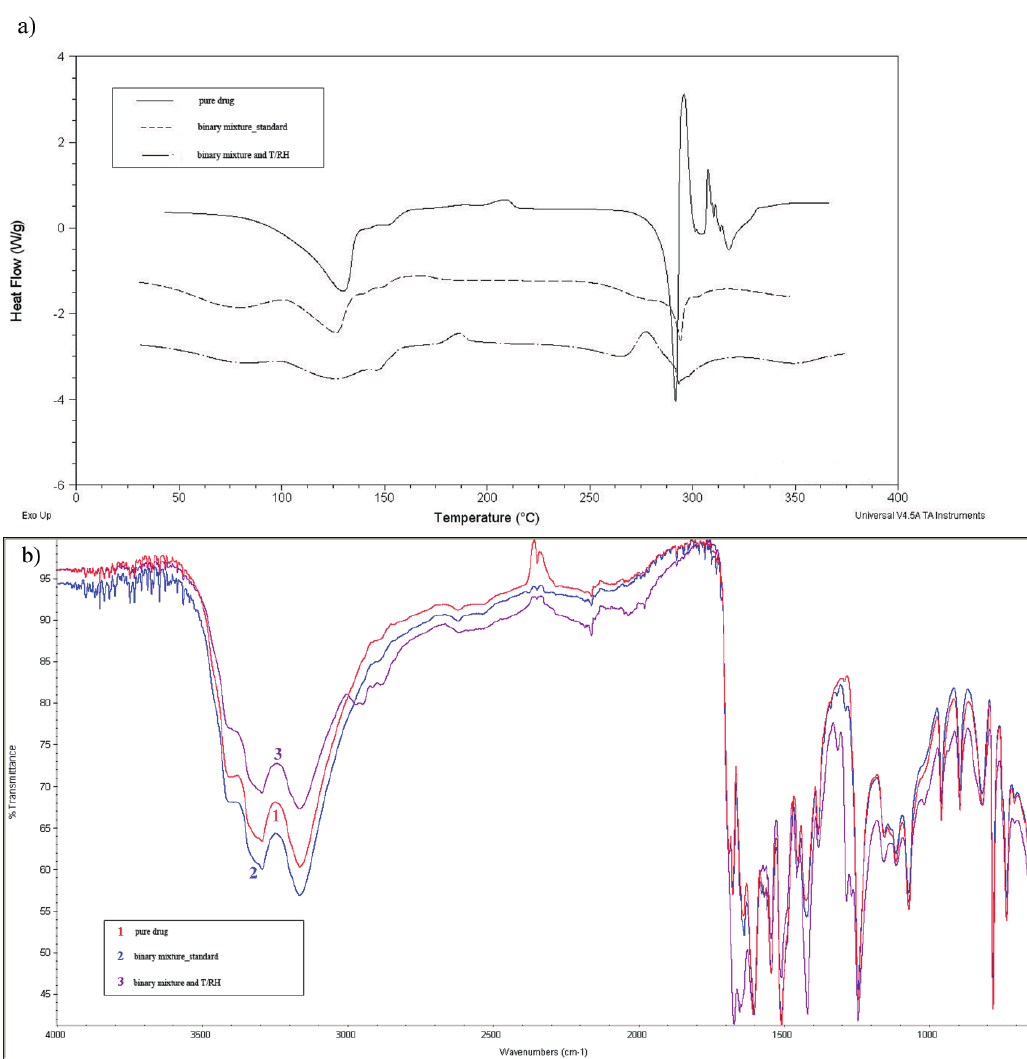
Figure 6 : Amiloride and PVP: DSC scans (a) and FT-IR spectra (b) for the mixture stressed with high temperature/humidity (T/RH) and the untreated mixture (standard) against pure